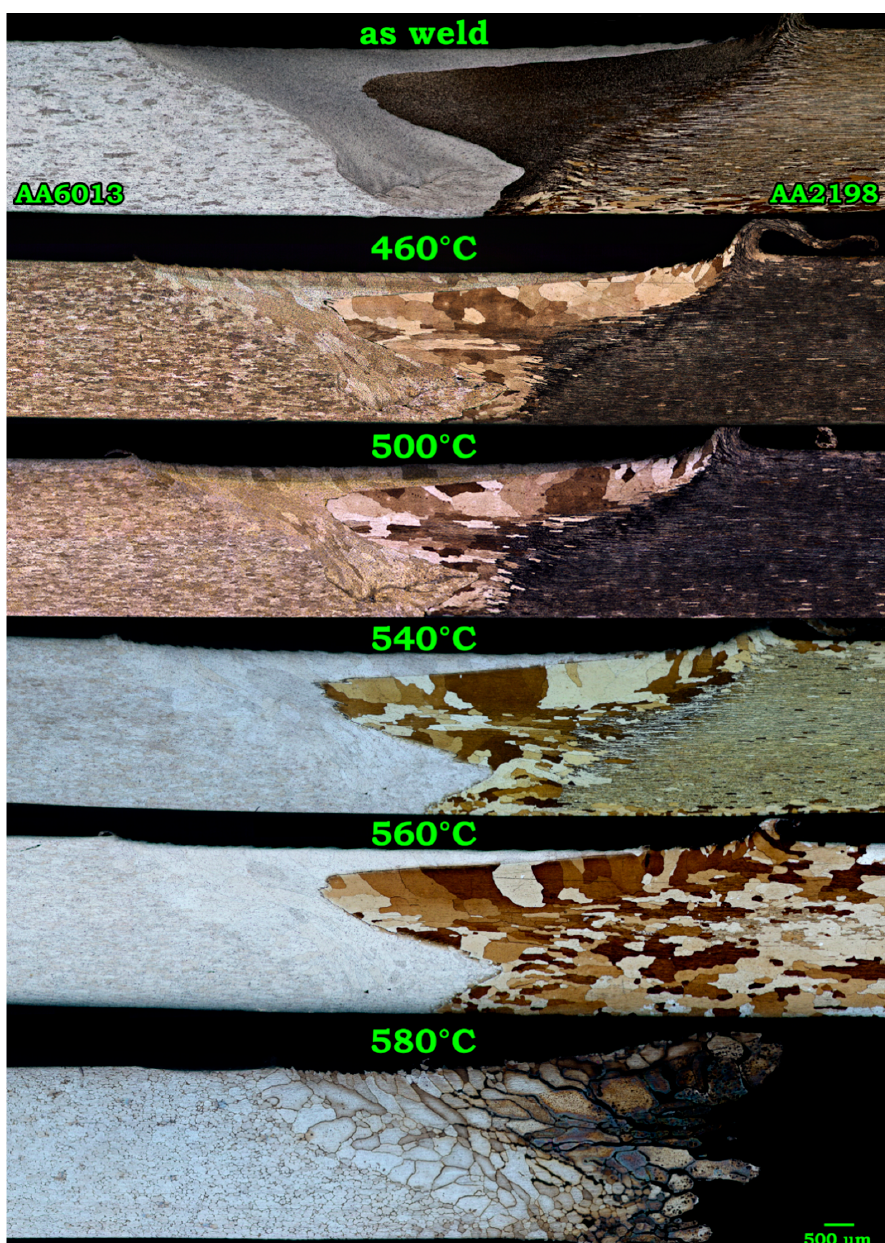
Figure 2. Microstructure evolution in the as-weld AA6013-AA2198 specimen subjected to annealing at 460–580 °C .